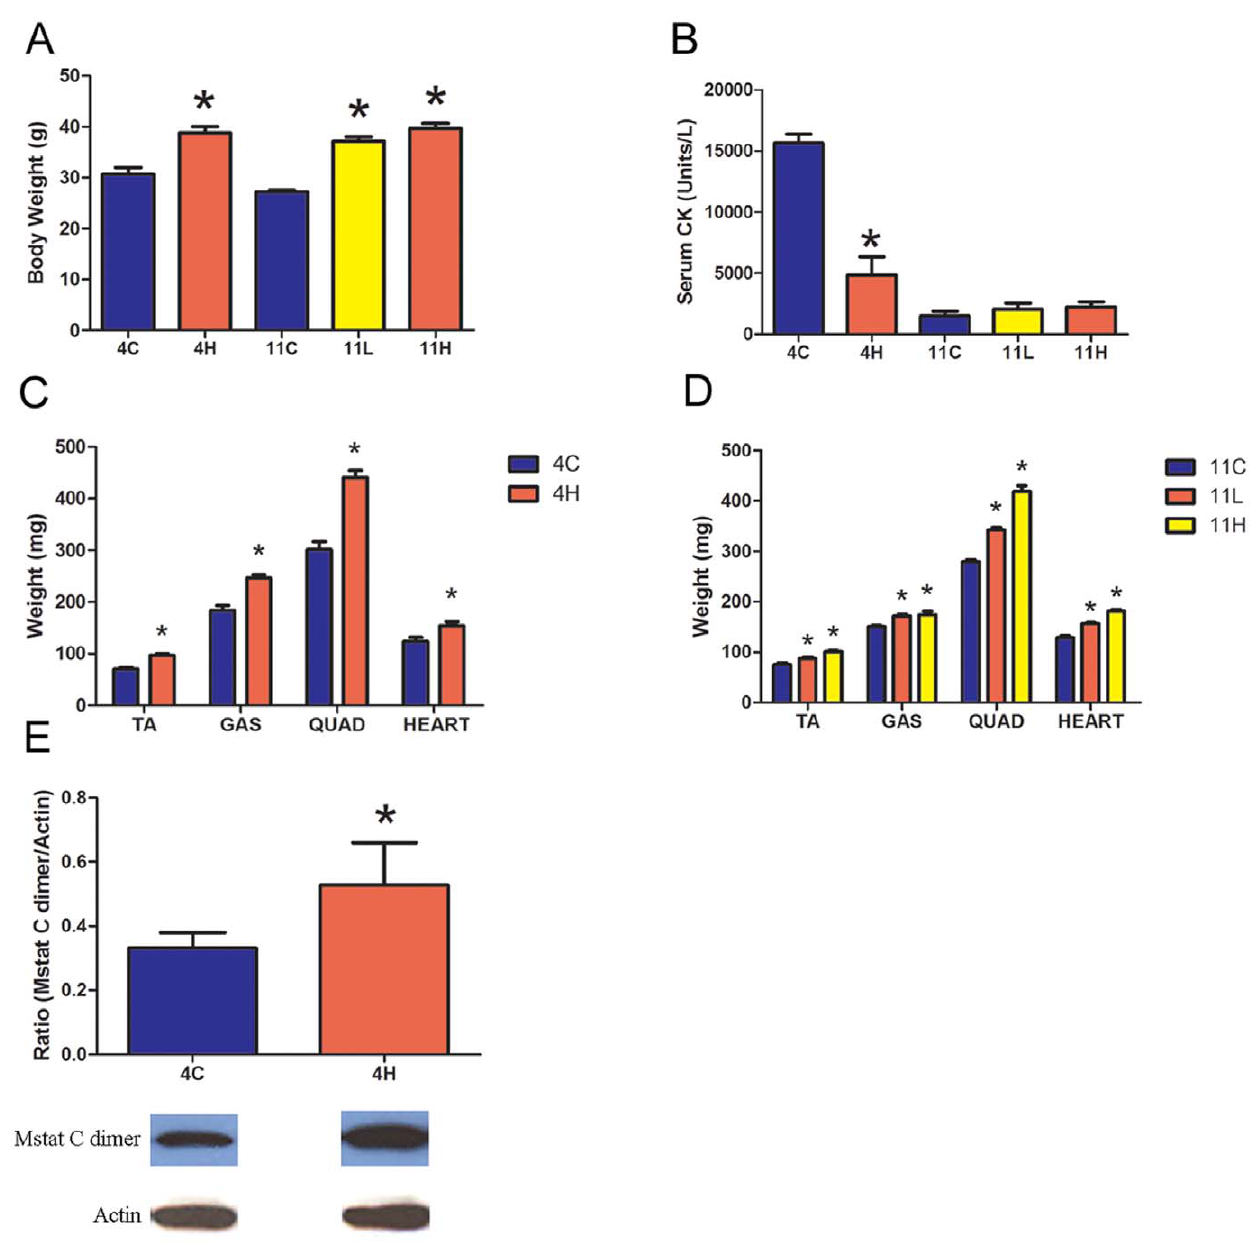
Figure 4. Effect of myostatin inhibition on body weight, serum creatine kinase and muscle weight in mdx mice. (a) Body weight was increased in all dnMstat treated groups. (b) Serum creatine kinase (CK) was reduced in the mdx 4H group in comparison to four month old mdx controls (4C), however it was not corrected in the mdx 11L and mdx 11H groups in comparison to eleven month old mdx controls (11C). (c) In the mdx 4H group, dnMstat overexpression increased the wet weight of the tibialis anterior (TA), gastrocnemius (GAS) quadriceps (QUAD) and heart. (d) At eleven months of age in the mdx 11L and 11H groups, these muscles continued to demonstrate increased mass. (e) Immunoblotting of mdx 4H quadriceps for the myostatin C terminus and beta-actin as a loading control revealed increased mature myostatin C dimer in treated muscles. Representative bands are shown. Data represent mean 6 SD. * Statistically significant compared to control, p , 0.05.